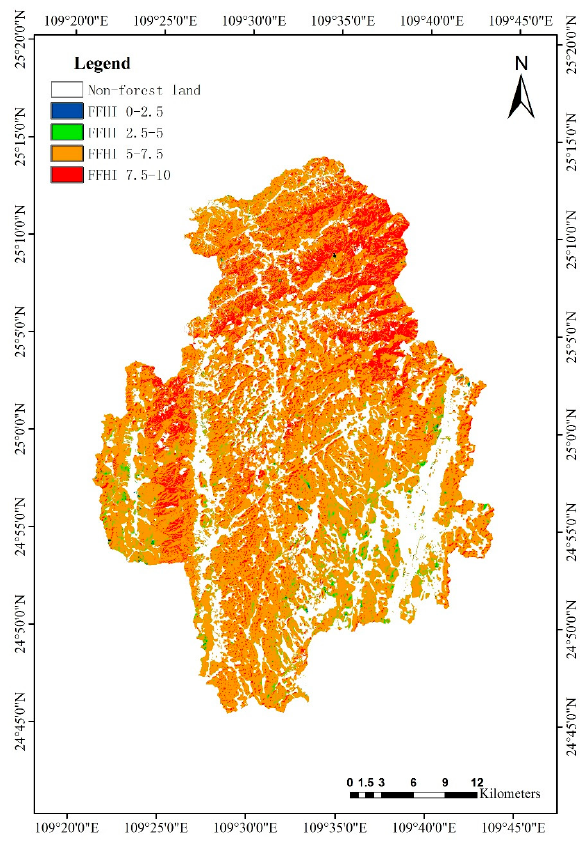
Figure 4. Thematic map of the final forest health index (FFHI) for a county in the Guangxi Autonomous Region.